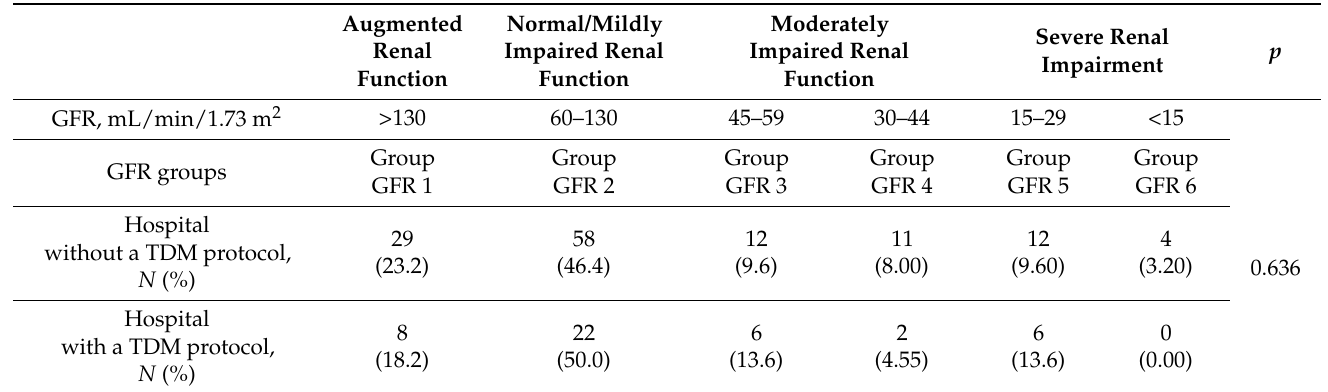
Table 2. Division of six GFR groups depending on GFR value.